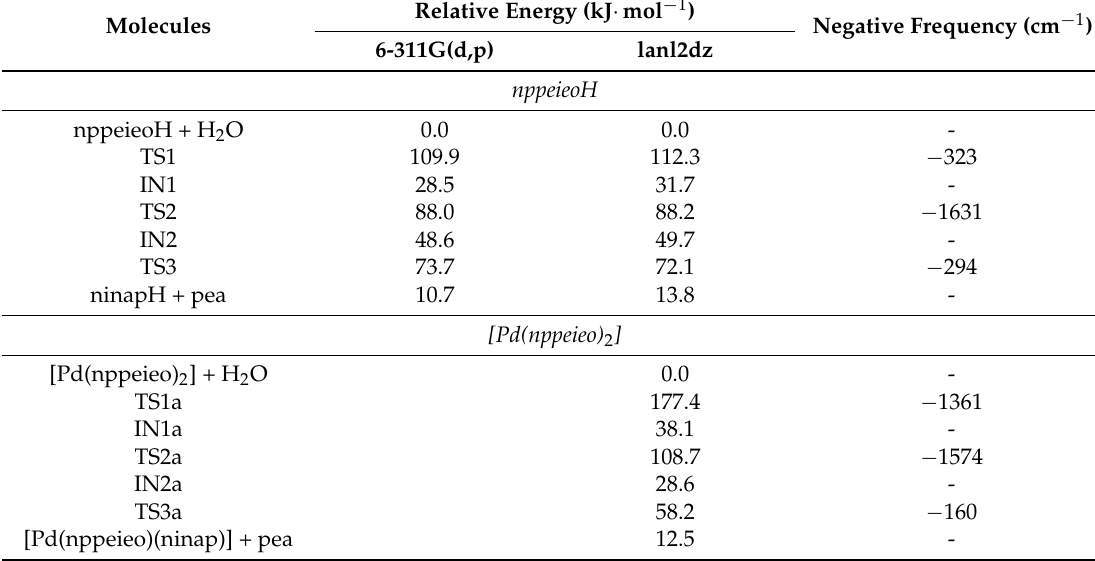
Table 1. Relative energy and negative frequency of the structures of the reaction paths for the hydrolysis of nppeieoH and [Pd(nppeieo) 2 ]. TS, transition state; IN, intermediate; pea,